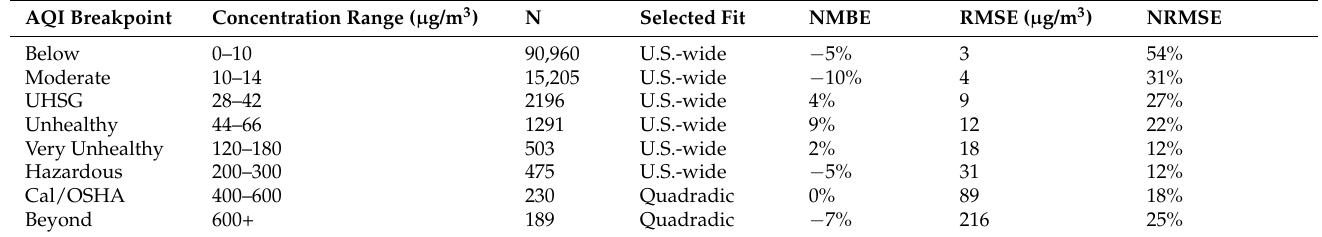
Table 4. The 1-h error at each AQI breakpoint, using site withholding and a transition from